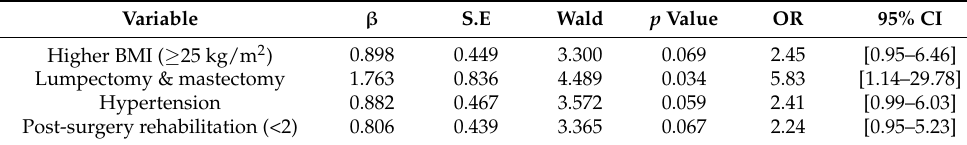
Table 4. Binary logistic regression analysis for the factors associated with